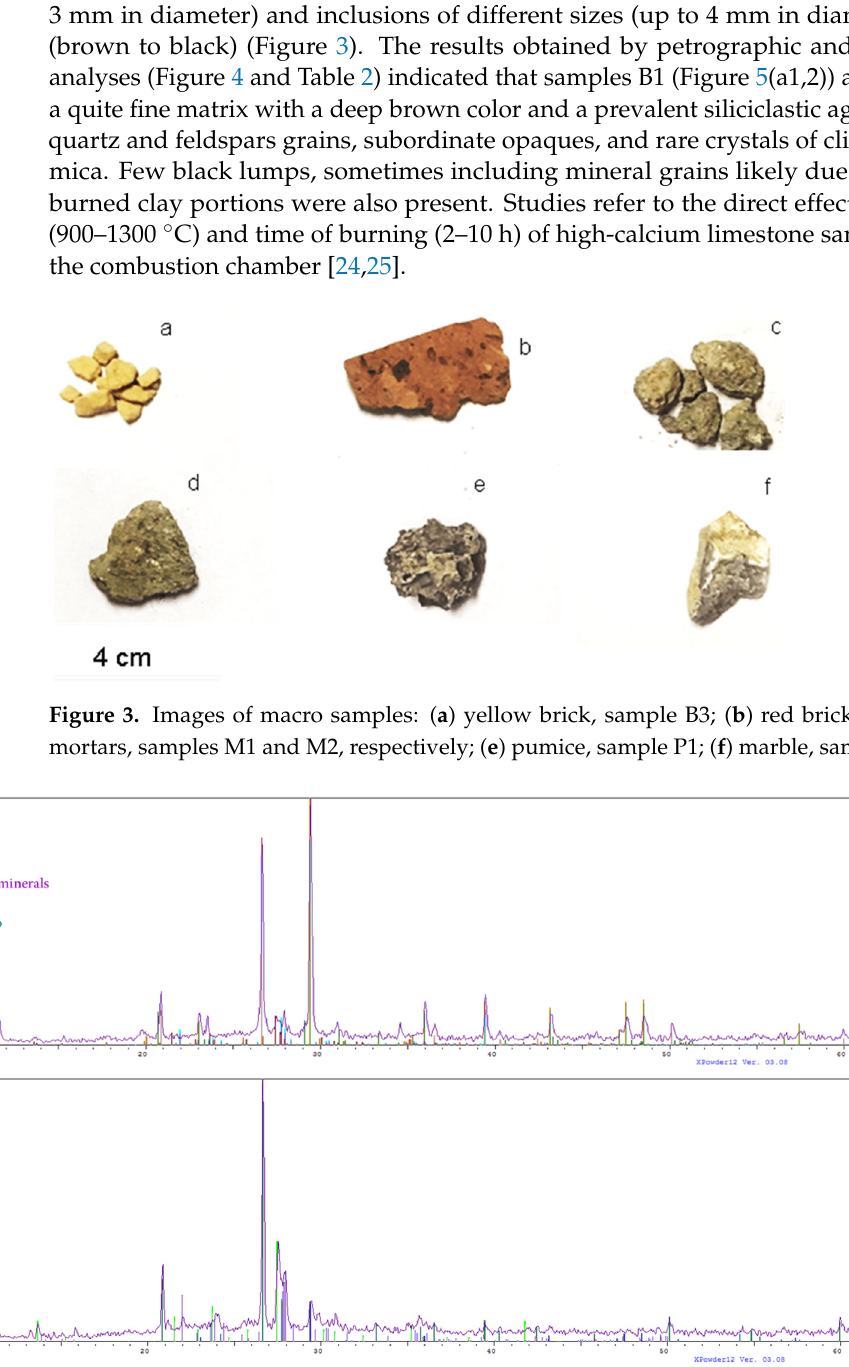
Figure 5. Microphotographs of brick samples. ( a ) sample B1; ( b ) sample B2; ( c ) sample B3 (yellow); ( d ) sample B4; a1, b1 c1 and d1 plane polarized light; a2, b2, d2, c2 crossed polarized light. All microphotographs are at 4× magnifications. bl = black lump; cs = carbonate shell; opx = orthopyroxene; qz = quartz; red arrows indicate firing stress lines. Line red bar = 1 mm.